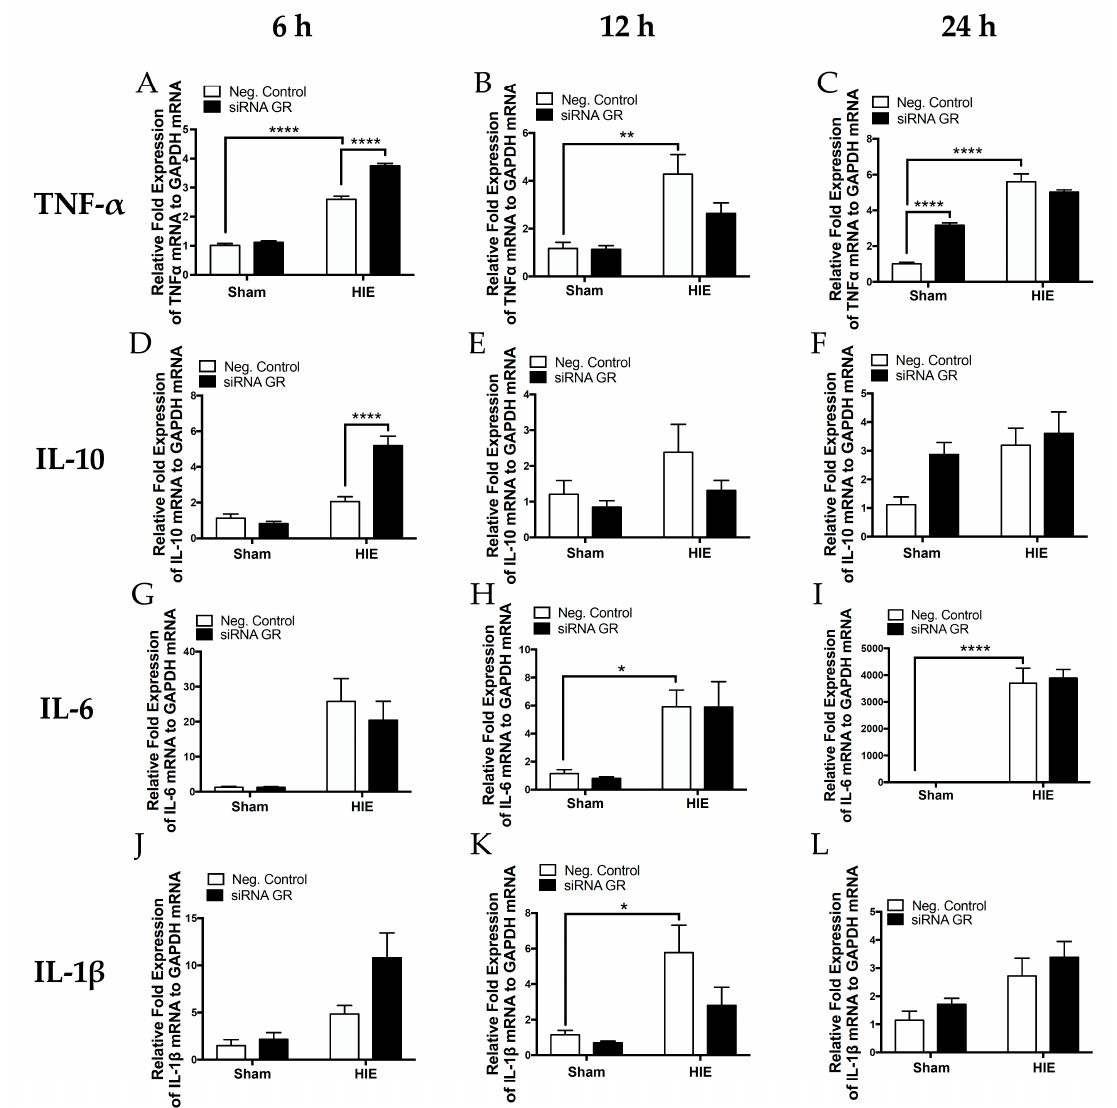
Figure 8. Repression of the GR increases cytokine profile 6 h after mild HI injury. The neonatal male rats received GR siRNA (100 pmol) or negative control (100 pmol) by ICV injection 48 h before HI-injury (8% FiO 2 ; 60 min). Groups were sham with negative control, sham with GR siRNA, negative control with HI injury, and GR siRNA with HI injury. Whole brain RNA was isolated at six, 12, and 24 h after HI injury and cytokines TNF- α ( A – C ), IL-10 ( D – F ), IL-6 ( G – I ), and IL-1 β ( J – L ). * p < 0.05, ** p < 0.01, **** p < 0.0001.